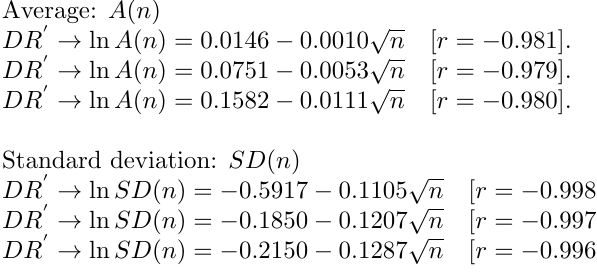
Sample distribution of the fuzzy risk indices DR Sample Average